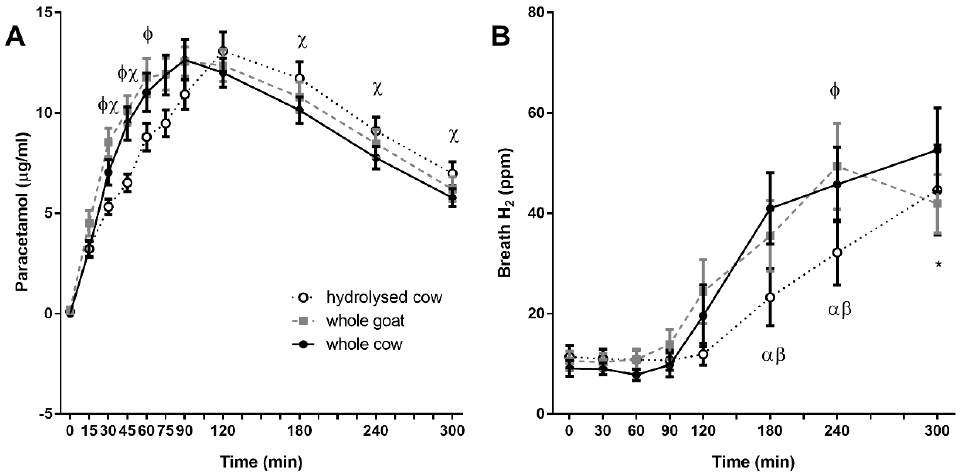
Figure 4. Postprandial plasma paracetamol ( A ) and breath hydrogen ( B ) responses. Values represent means ± SEM in µ g/mL ( A ) and ppm ( B ). There was a time × treatment interaction for postprandial